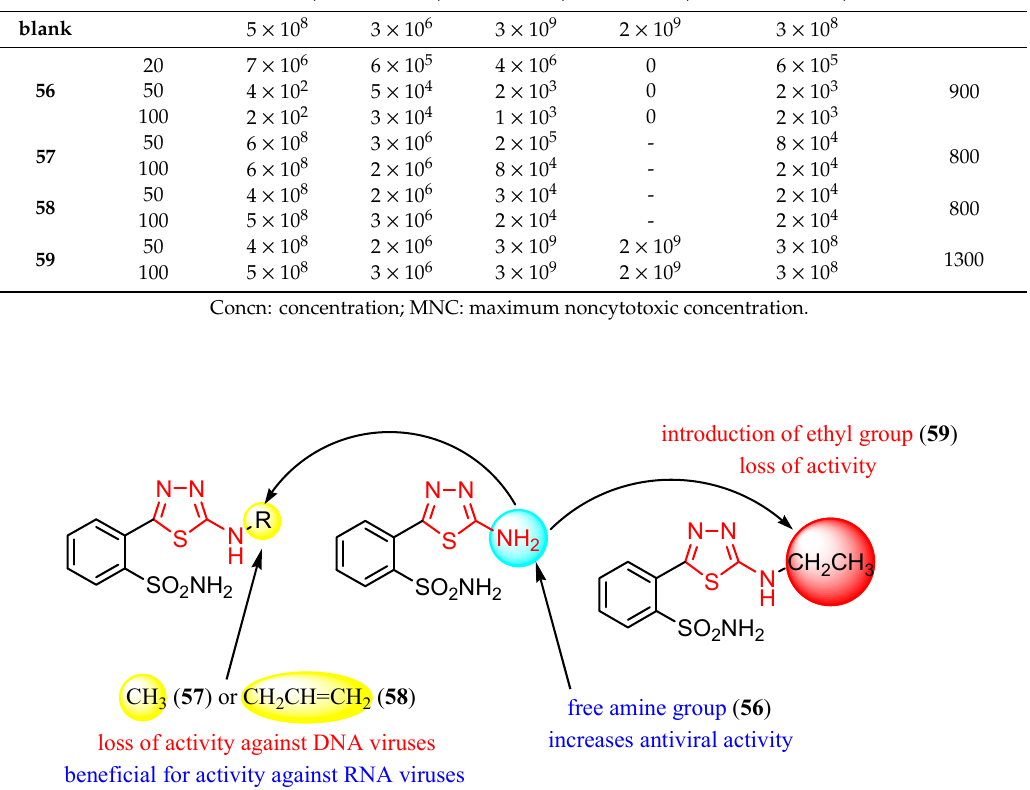
Figure 8. The influence of substituents of 1,3,4-thiadiazole derivatives 56 – 59 on antiviral activity. Cui et al. synthesized several pyrrolyl-1,3,4-thiadiazoles with general formula 60 (Figure 9). The compounds showed antiviral activity against some viruses of the Flaviviridae family such as West Nile virus and dengue virus [25,104].